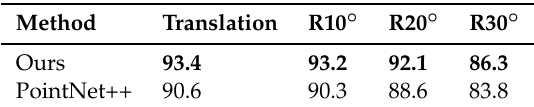
Figure 2. The architecture for classification. This model takes N points as an input and mainly contains two branches. The upper branch functions as a regular network to output the global feature. The lower branch is a global attention module which outputs the global attention mask representing different importance of each point. We directly operate an element-wise multiplication between the feature and mask. Finally, we feed the outcome of this multiplication into the classification and segmentation network to obtain the scores. c 1 and c 2 denote the dimensions of features. k represents the quantity of points x i sampled in a ball centered at x c . m denotes the number of classes. The “++” of “CW EdgeConv++” means that there is additional output from it for the global attention module. The dimensions annotated in CW-EdgeConv and Global Attention Module (all blue boxes) are for per-point features. Table 1. Robustness to translation and rotation in terms of classification accuracy. We evaluate the test data with uniform translation in [ − 0.2, 0.2 ] and the different rotation with 10 ◦ , 20 ◦ , and 30 ◦ . There is no point set rotation in the phase of data augmentation during